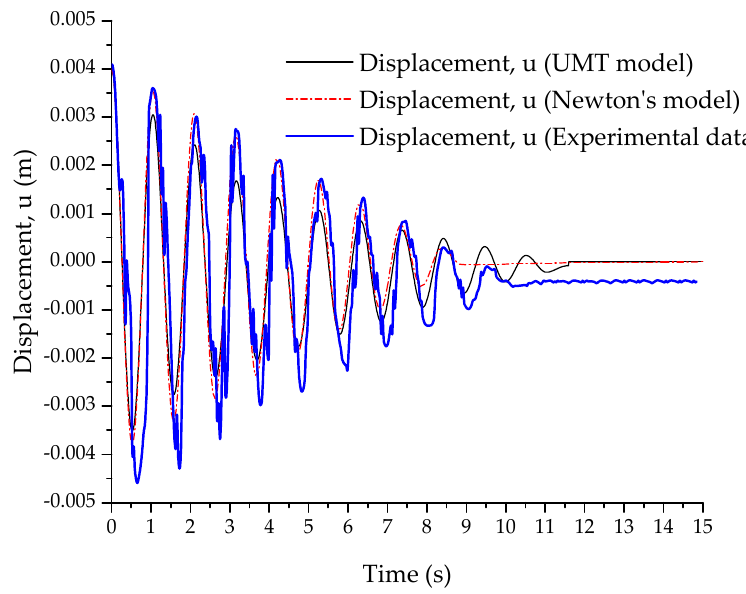
Figure 8. Comparison between model predictions and test data [47] for the displacement versus time data.